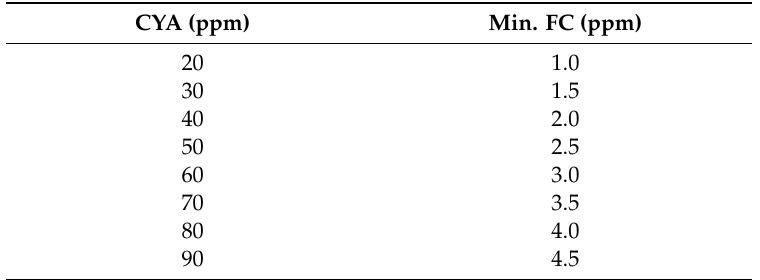
Table 9. Required minimum free chlorine for given cyanuric acid